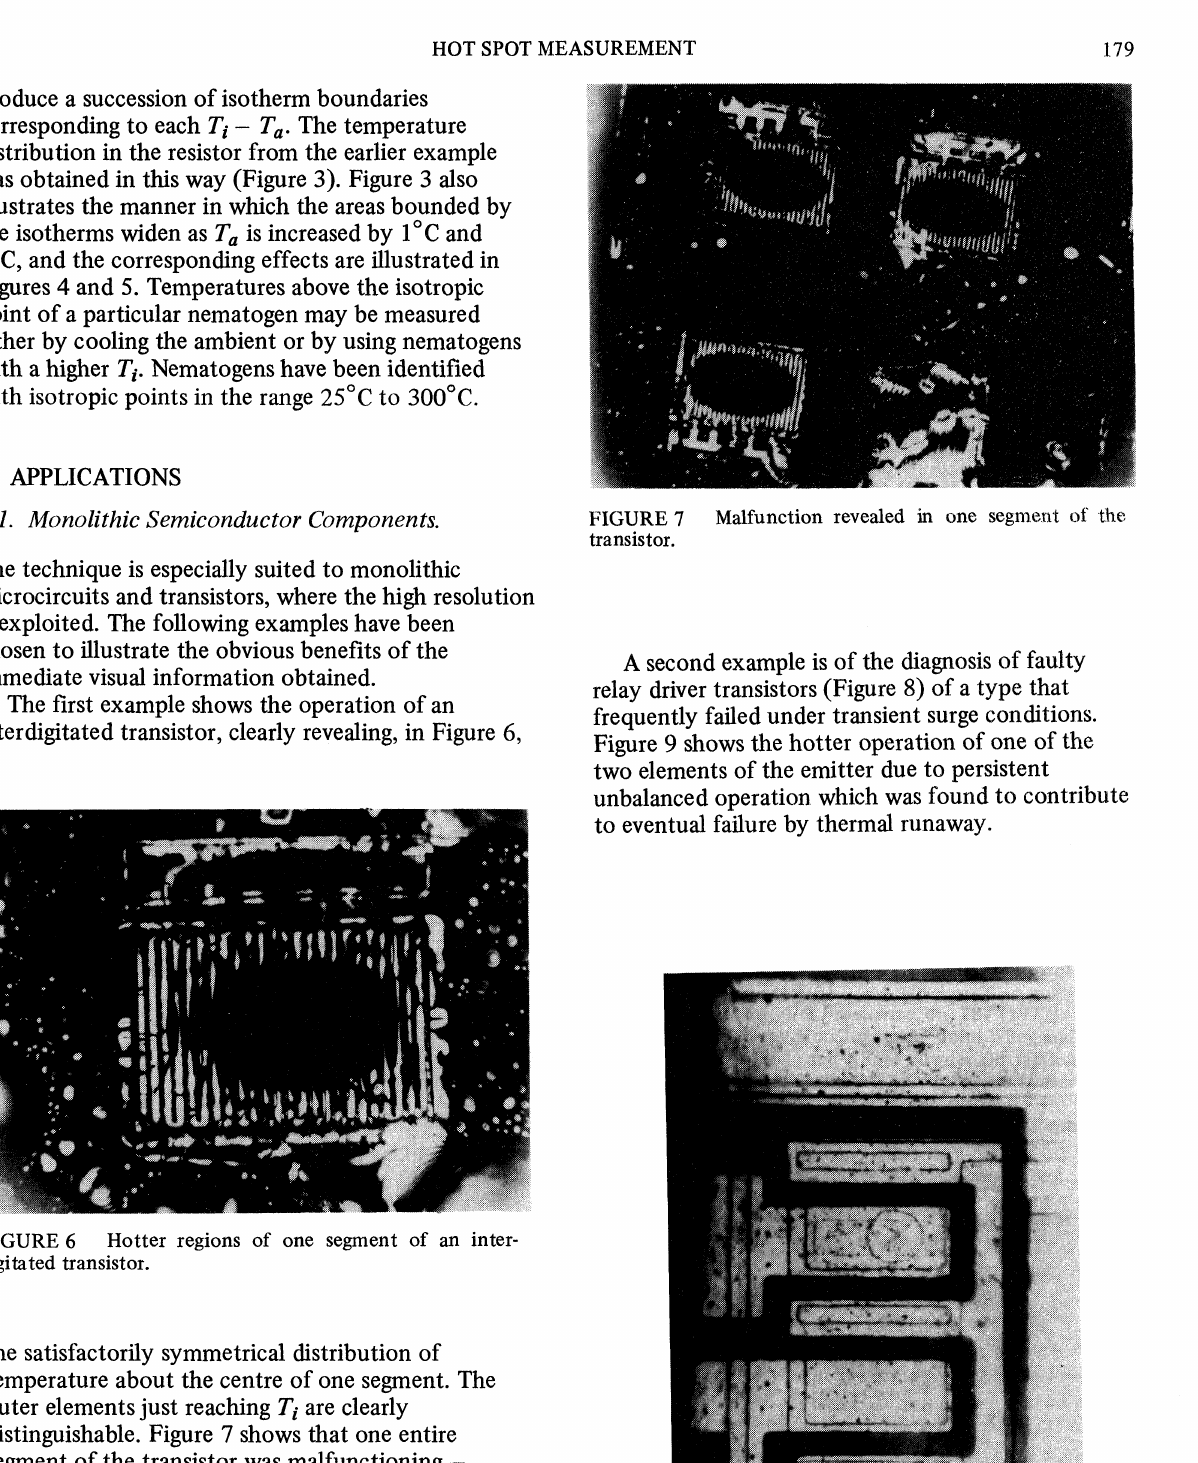
Photomicrograph of relay-driver